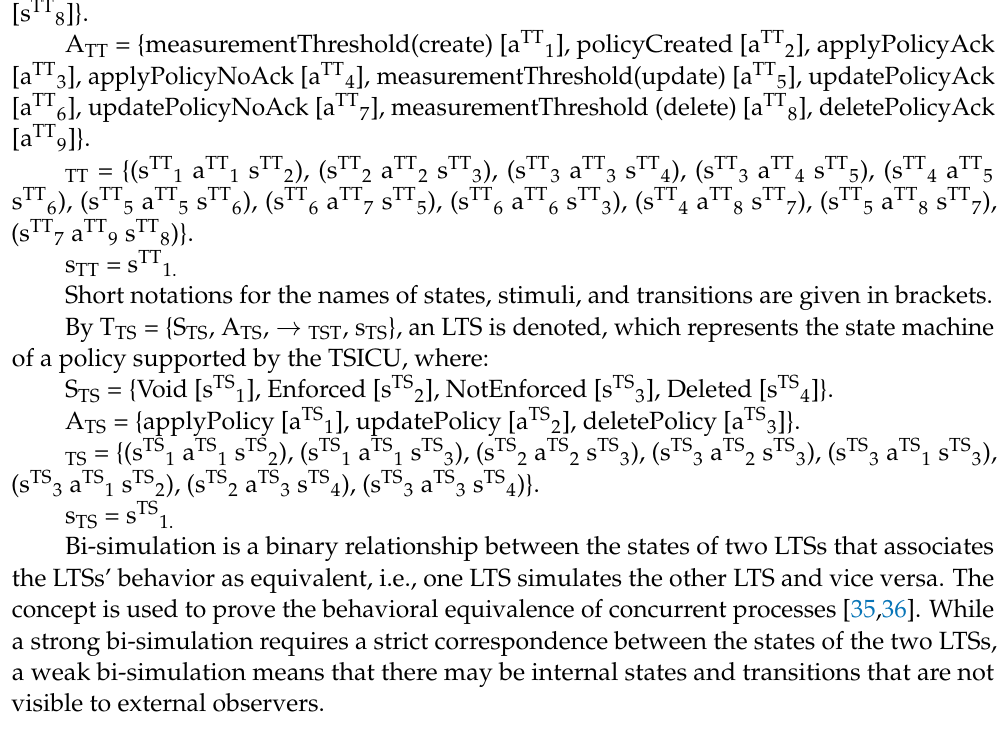
Figure 12. Model representing the rail policy state as seen by the TSICU.